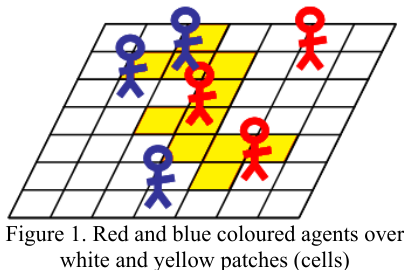
Figure 1. Red and blue coloured agents over white and yellow patches (cells)